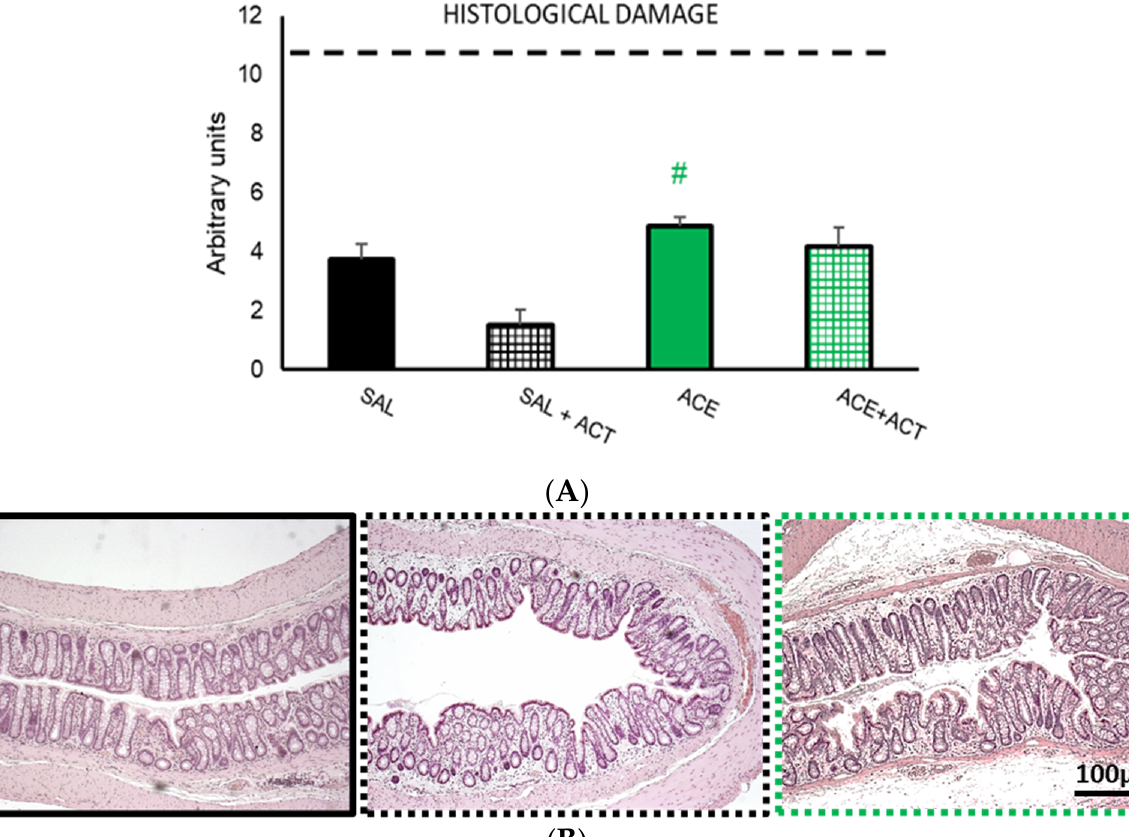
Figure 8. Effects of pretreatment with probiotics on colonic damage, phase II. The groups selected in phase I (SAL30 and ACE 0.6% 30, now termed SAL, black bar and ACE, green bar) were compared with the corresponding two groups that were pretreated with 1 mL/day of Actimel ® (ACT) (SAL + ACT black gridded bar, ACE + ACT green gridded bar). Histological damage ( A ) was measured in ten random fields per section stained with HE. Maximum damage was represented by 11 points (dotted line). Data represent mean ± SEM. # p < 0.05 vs. SAL + ACT. One-way ANOVA followed by Bonferroni post hoc test ( n = 8–13). ( B ) Photomicrographs of colonic samples stained with H/E after intracolonic administration of SAL (black frame) or in animals pretreated with Actimel ® after intracolonic administration of saline (black dotted frame) or 0.6% acetic acid (green dotted frame). Scale bar = 100 μm .